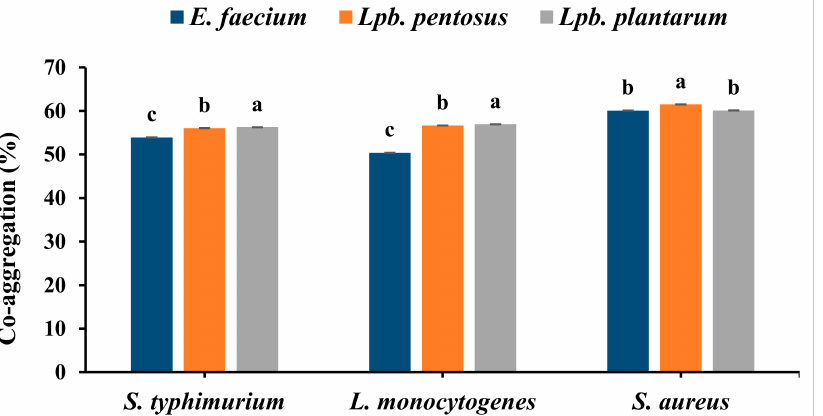
Figure 4. Co-aggregation of E. faecium , Lpb. plantarum , and Lpb. pentosus . Different letters indicate significant differences between samples at p ≤ 0.05.